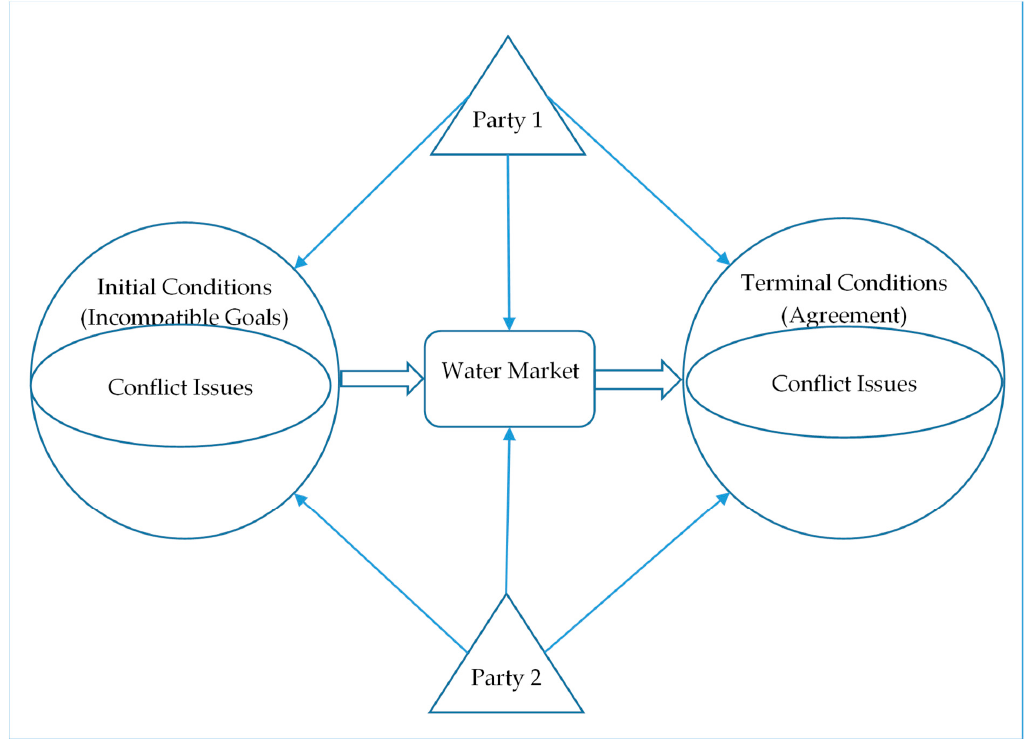
Figure 5. Structure of Water Market Mechanism.